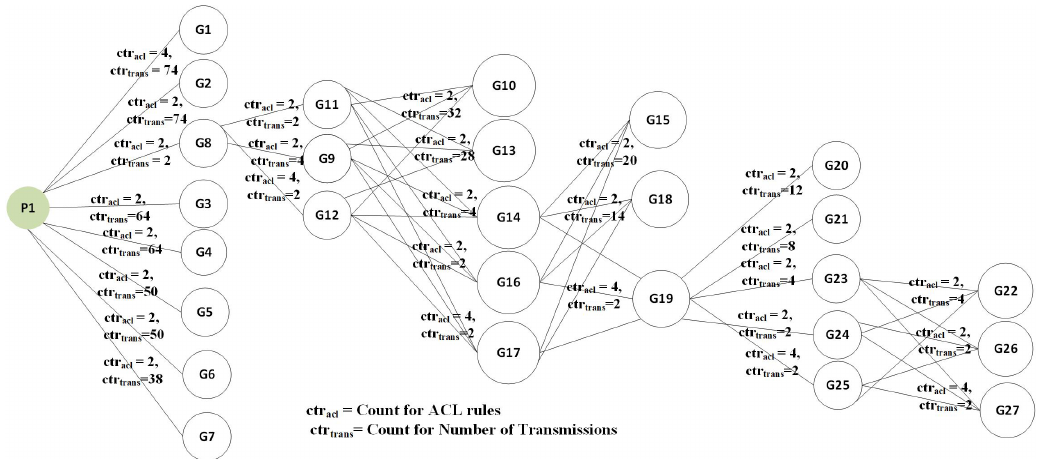
Figure 12. K-partite Graph that shows the different combinations of switch port to install ACL policies. Shortest path for entire K-partite graph is calculated that gives the optimal policy implementation